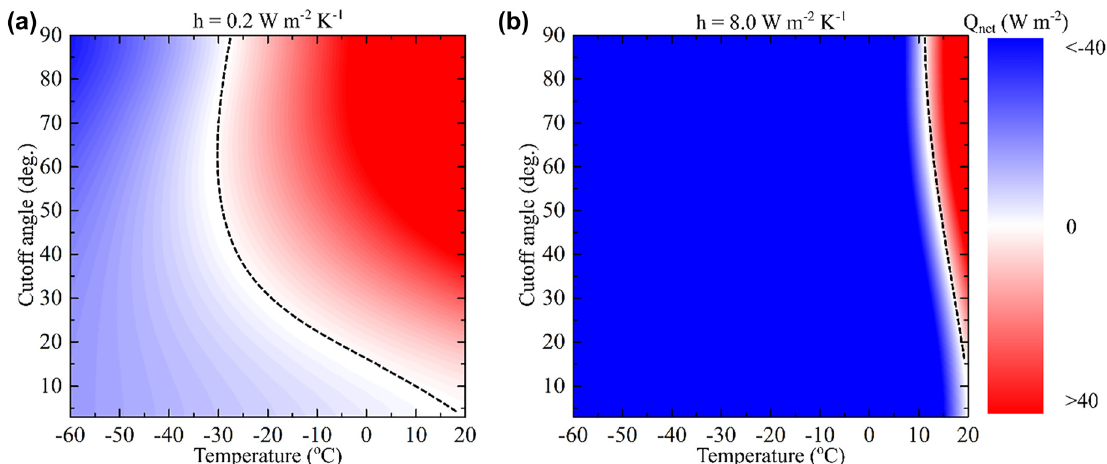
Figure 4: Effect of parasitic heating on the performance of angularly and spectrally selective thermal emitter at an effective heat transfer coefficient (a) h = 0.2 W m − 2 K − 1 and (b) h = 8 W m − 2 K − 1 . Decreasing the cutoff angle does not guarantee a better performance due to the ∼ 55 ◦ for (a), while for (b) decreasing the cutoff angle increases the equilibrium temperature. . We find an optimal 𝜃 decrease in Q sample Cuttoff